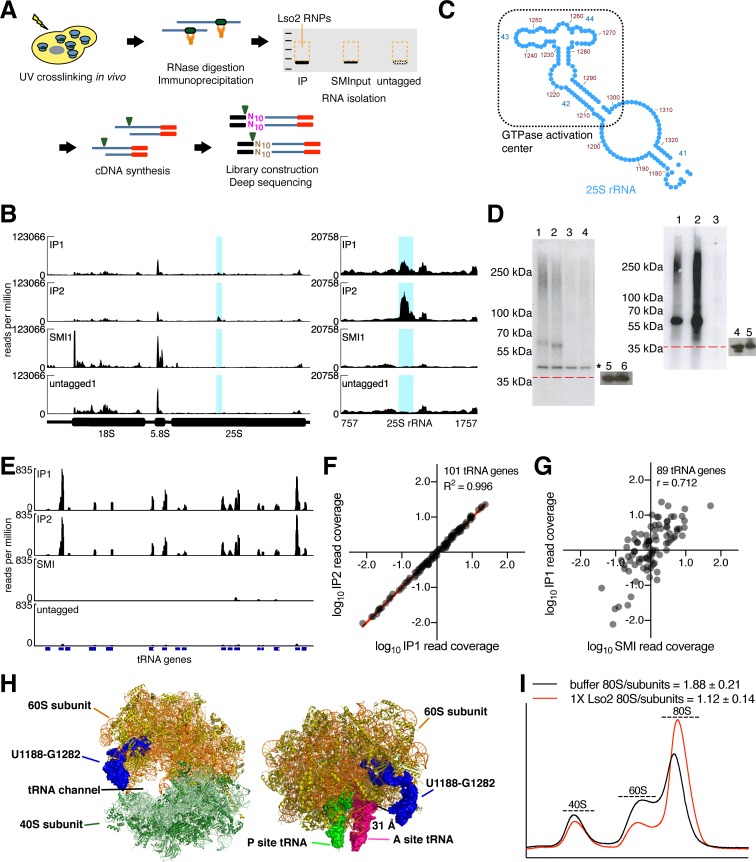
Lso2 crosslinks to 25S rRNA near the A site and to tRNAs.(A) Overview of ePAR-CLIP library construction. (B) (Left) Normalized read coverage across the RDN37 locus in ePAR-CLIP libraries prepared with 1:20,000,000 RNase I. The y-axis is reads per million reads in the entire library. Two untagged IP libraries and 2 SMI libraries, each strain-matched to an IP replicate, were the controls in this set. One SMI and 1 untagged library are shown for clarity. Blue bars indicate the region that was significantly enriched (fold-enrichment > 4, p < 10−5) in both IP replicates relative to its paired SMI, as well as to the 2 untagged libraries. (Right) Inset of normalized read coverage across the enriched region in RDN25. (C) Secondary structure of the subregion of 25S rRNA [47] containing the Lso2 crosslink cluster. Helices 42, 43, and 44 comprise the GTPase activation center. (D) (Left) Diagnostic electrophoresis membrane of radiolabeled Lso2-RNPs from ePAR-CLIP libraries prepared with 1:20,000,000 RNase I. The red line indicates the position of Lso2-Myc alone (without crosslinked RNAs), based on the positions of protein markers. Lanes 1 and 2, IP replicates; lanes 3 and 4, untagged replicates; lanes 5 and 6, western blots of Lso2-Myc in 0.5% of the input and in 13% of the IP, respectively. The region from 50 kDa to approximately 130 kDa was excised for each sample. Asterisk indicates a nonspecific labeled RNA species present in all libraries. (Right) As in left, except from ePAR-CLIP libraries prepared with 1:2,000,000 RNase I. Lanes 1 and 2, IP replicates; lane 3, untagged; lanes 4 and 5, western blots of Lso2-Myc in 0.5% of the input and in 13% of the IP, respectively. The region from 35 kDa to 100 kDa was excised for each sample. (E) Normalized read coverage across a series of negative strand tRNA features in ePAR-CLIP libraries prepared with 1:2,000,000 RNase I. The y-axis is reads per million reads in the entire library. Blocks represent exons, while thin lines represent introns. (F) Correlation of tRNA read densities between the IP replicates made with 1:2,000,000 RNase I. Read density values were median centered and log10 transformed. R2 of linear fit is indicated. (G) Correlation of tRNA read densities between IP replicate 1 versus the SMI for ePAR-CLIP libraries made with 1:2,000,000 RNase I. Read density values were median centered and log10 transformed. (H) (Left) The rRNA crosslink cluster from (B) on the crystal structure of the 80S ribosome ([48], PDB 4V88). (Right) The identical cluster on a cryo-EM structure of the 60S subunit containing P and A site tRNAs in the classic state ([49], PDB 5GAK). (I) Lso2 stabilizes ribosomal subunit association in vitro. One μM each (100 pmol) of 40S subunits and 60S subunits purified from yeast lso2Δ was mixed with 1 μM (100 pmol) of purified recombinant Lso2 or with an equivalent volume of buffer. The mixture was incubated at 37°C for 10 minutes before fractionation through a sucrose gradient. The ratio of 80S ribosomes to the sum of 40S and 60S subunits was quantified. n = 3 technical replicates; mean ± S.D. See also S2 Fig and S2 Table. EM, electron microscopy; ePAR-CLIP, photoactivatable ribonucleoside crosslinking and immunoprecipitation and an enhanced method of CLIP library preparation; IP, immunoprecipitation; Lso2, late-annotated short open reading frame 2; Lso2-Myc, yeast strains expressing Myc-tagged Lso2 at endogenous levels; PDB, Protein Data Bank; RNP, ribonucleoprotein; rRNA, ribosomal RNA; SMI, size-matched input.